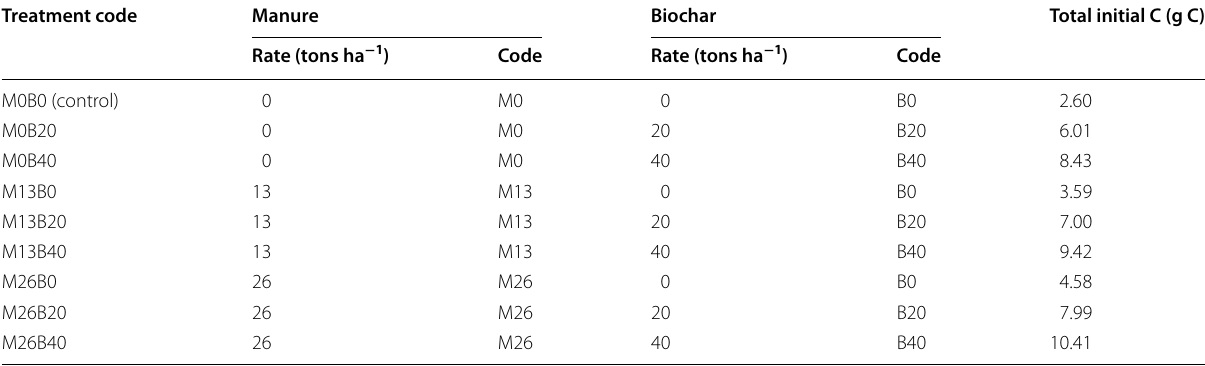
Table 2 Experimental treatments for evaluating the effect of biochar and manure on C mineralization in a sandy soil Treatment